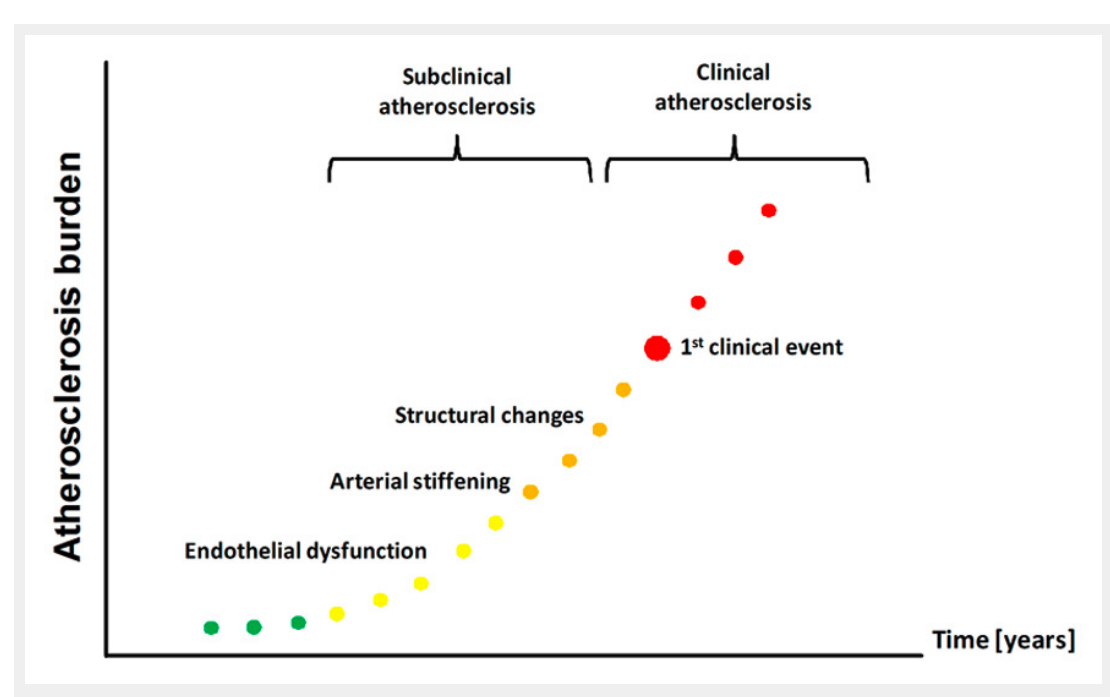
Figure 1 Atherosclerosis burden starts early in life. Endothelial dysfunction, arterial stiffening and structural alterations of the arterial wall represent early steps in the development of atherosclerosis that are already detectable in children known to be at increased cardiovascular risk later in